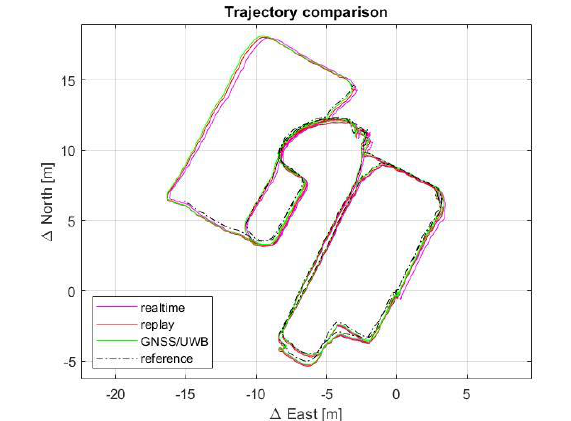
Figure 9. The top-view trajectory estimation comparison between real-time, replay and GNSS/UWB solutions.